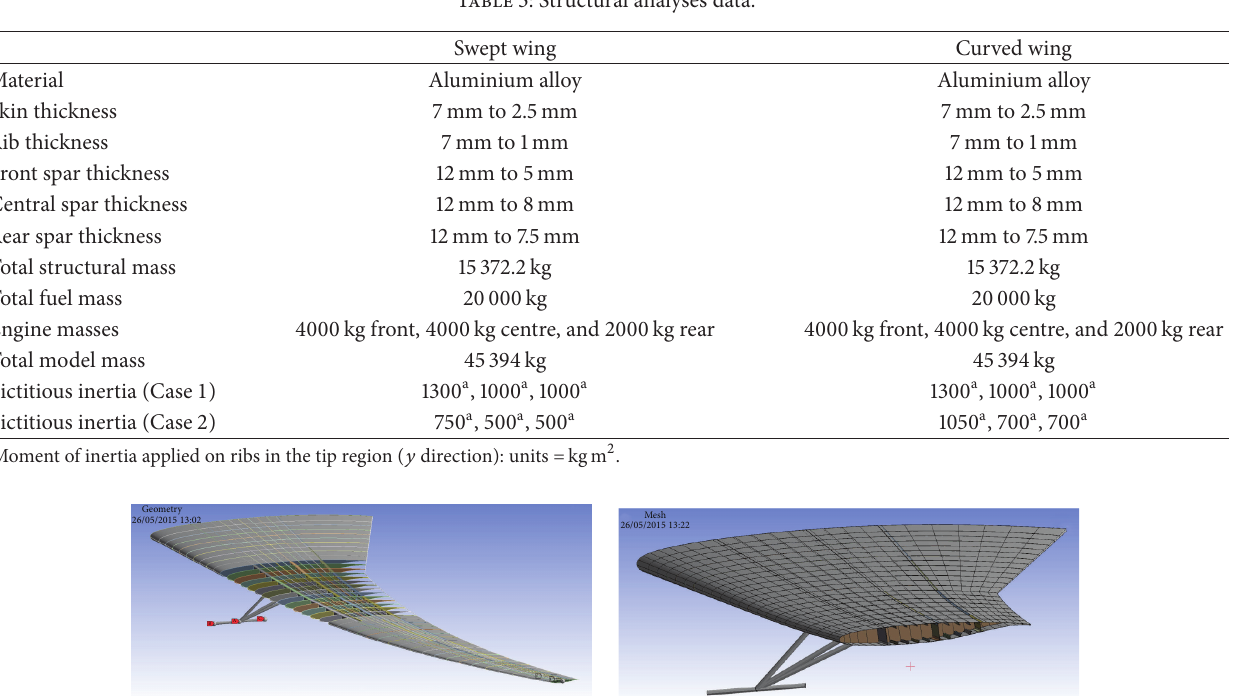
Table 3: Structural analyses data.